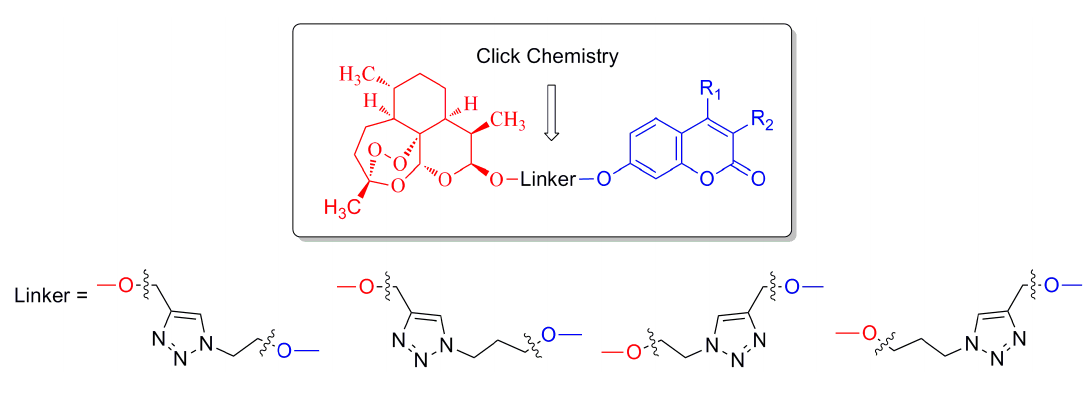
Scheme 1. The design of target